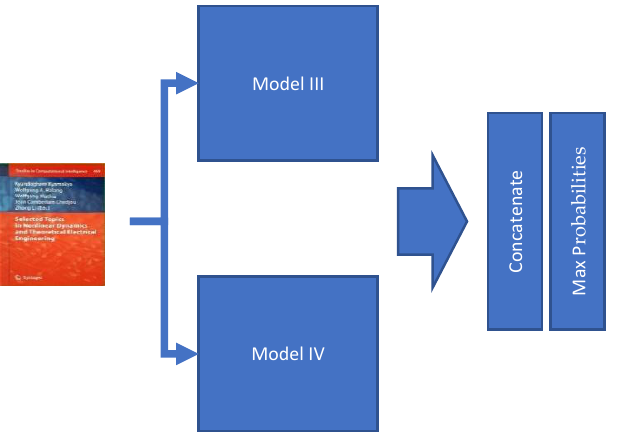
Figure 11. Model V does integrate two of the previous models, namely Model III and Model IV. First, it does classify the document image separately by the two integrated models and then finally concatenates and calculates maximum probabilities to determine the most probable class of the document